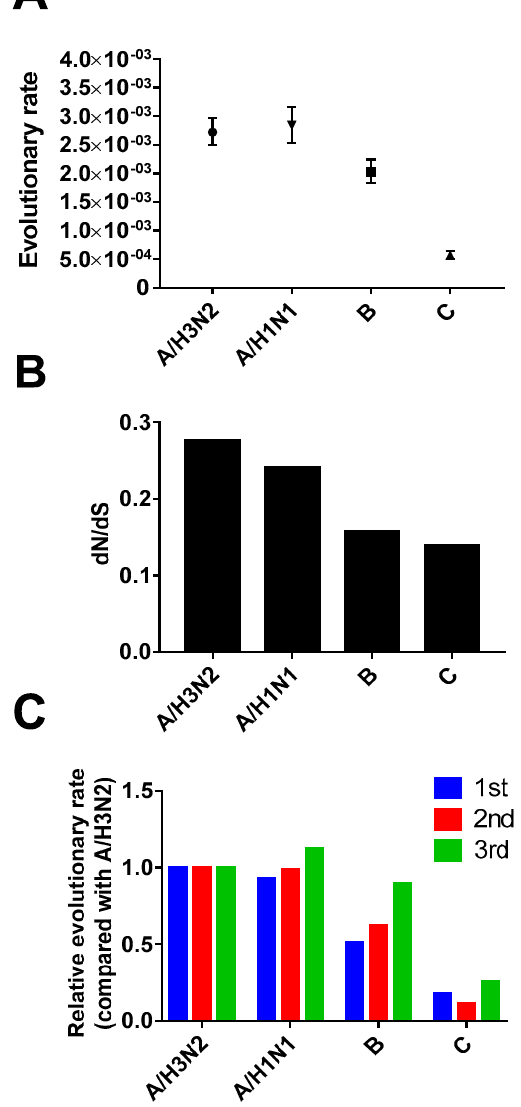
Figure 4. Evolutionary rate and selection pressure of influenza A, B, and C viruses. ( A ) Evolutionary rate (nucleotide substitution per site per year); ( B ) selection pressure (relative rate of non-synonymous and synonymous mutation); and ( C ) relative evolutionary rate of each position in the codon compared with the influenza A/H3N2 virus. In all three panels, results were calculated using data of the HA gene for influenza A and B viruses and the HE gene for the influenza C virus. Error bars show 95% highest posterior density intervals.